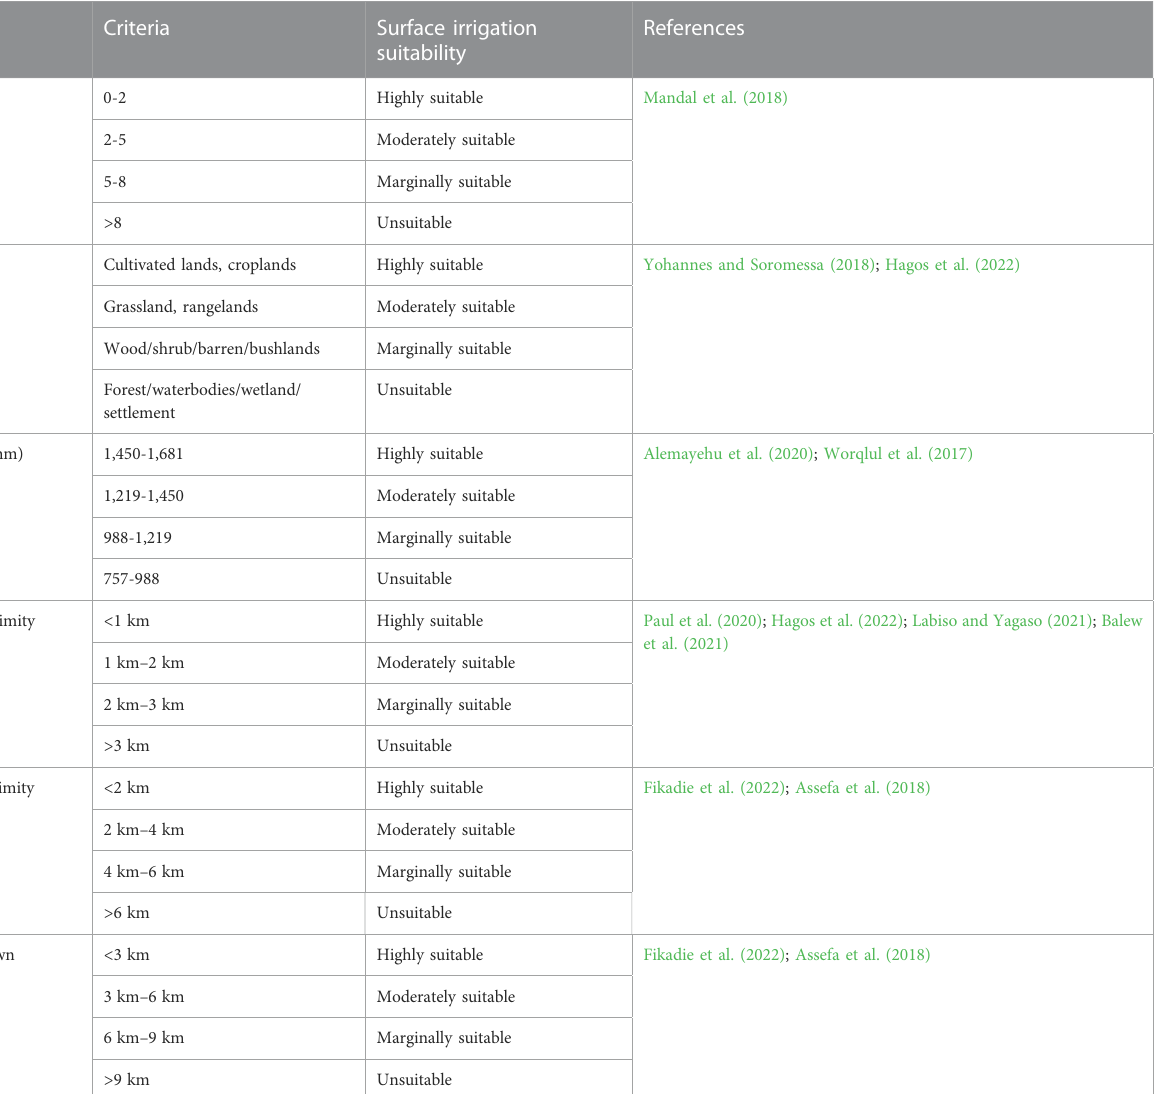
TABLE 2 Assessment of surface irrigation suitability